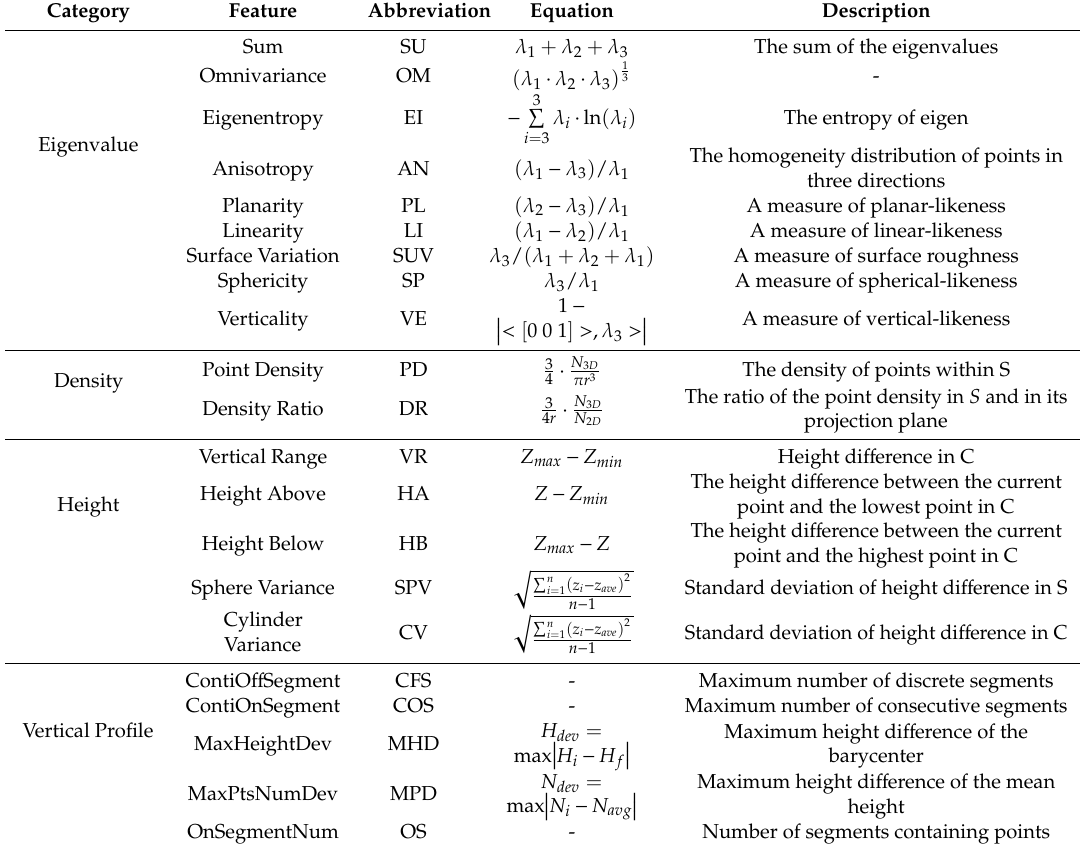
Table 3. Feature vector description. The first column represents the basis of feature computing, the second column is the feature name, the third column is the feature abbreviation, the fifth column is the feature computing method, and the last column is the description of the feature